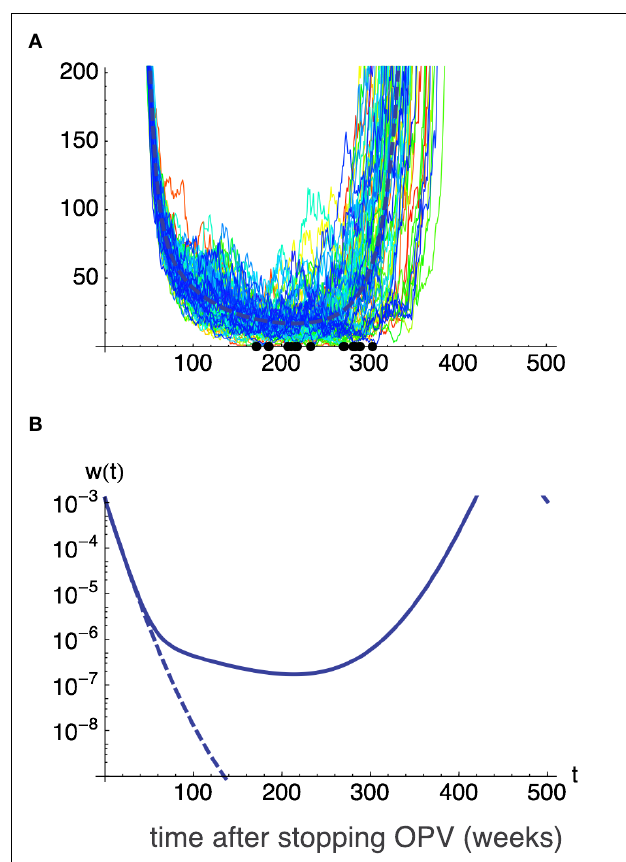
FIGURE 8 |The effect of a high-risk group on global eradication. One in 10,000 (0.01%) of hosts are assumed to be born having a longer excretion period (lower recovery rate γ (cid:3) ) when infected by virus. Remaining hosts have the recovery rate γ . γ (cid:3) = 0.1 γ and γ = 0.2 is assumed and values p = 0.7, β = 2.5, μ = 0.1, u = 0.00025, K = 10 8 are used for other parameters.Without the high-risk group, i.e., when all hosts have the recovery rate γ = 0.2, global eradication is certain. However, with the addition of a fraction 0.01% of high-risk group in the population, eradication fails in 79 out of 100 independent runs, allowing the outbreak of virulent virus. (A) Sample paths for the number of infecteds for 100 independent runs.Thick broken lines show the deterministic trajectory. (B) Deterministic trajectories for the fraction of infected w ( t ) when all hosts have the recovery rate γ (broken line), and when 0.01% of hosts have lower recovery rate γ (cid:3) (solid